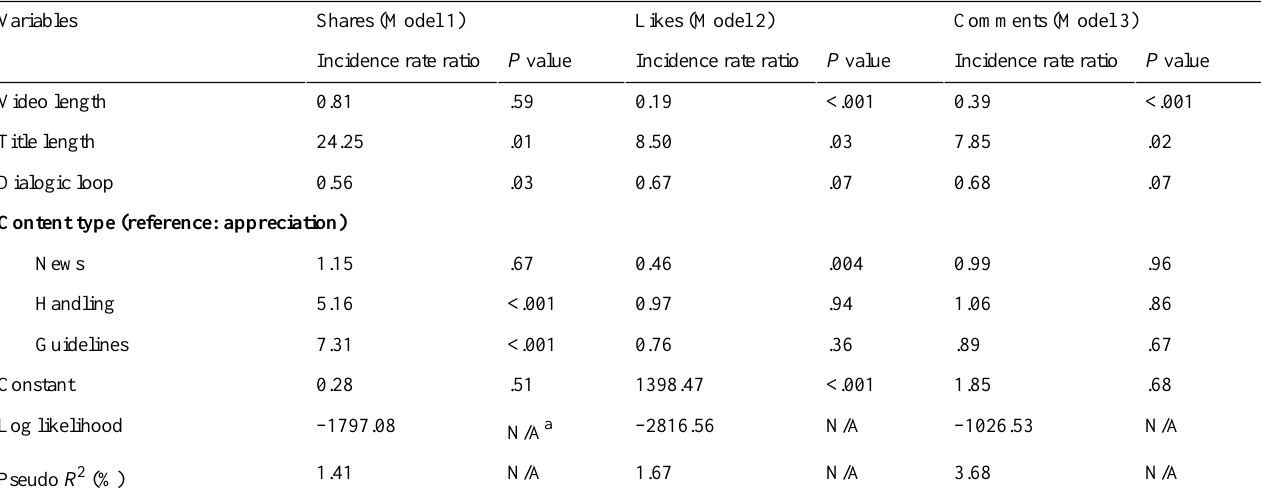
Table 2. Predicting citizen engagement with government social